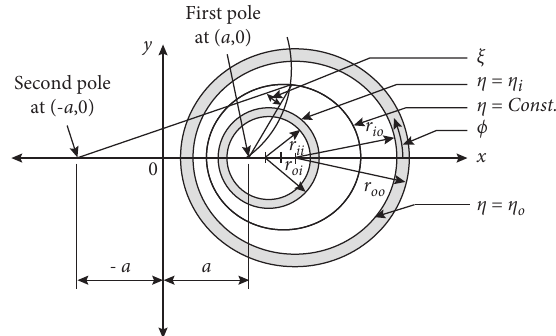
Figure 1: Bipolar and cylindrical coordinate systems in a 2D cross section of the